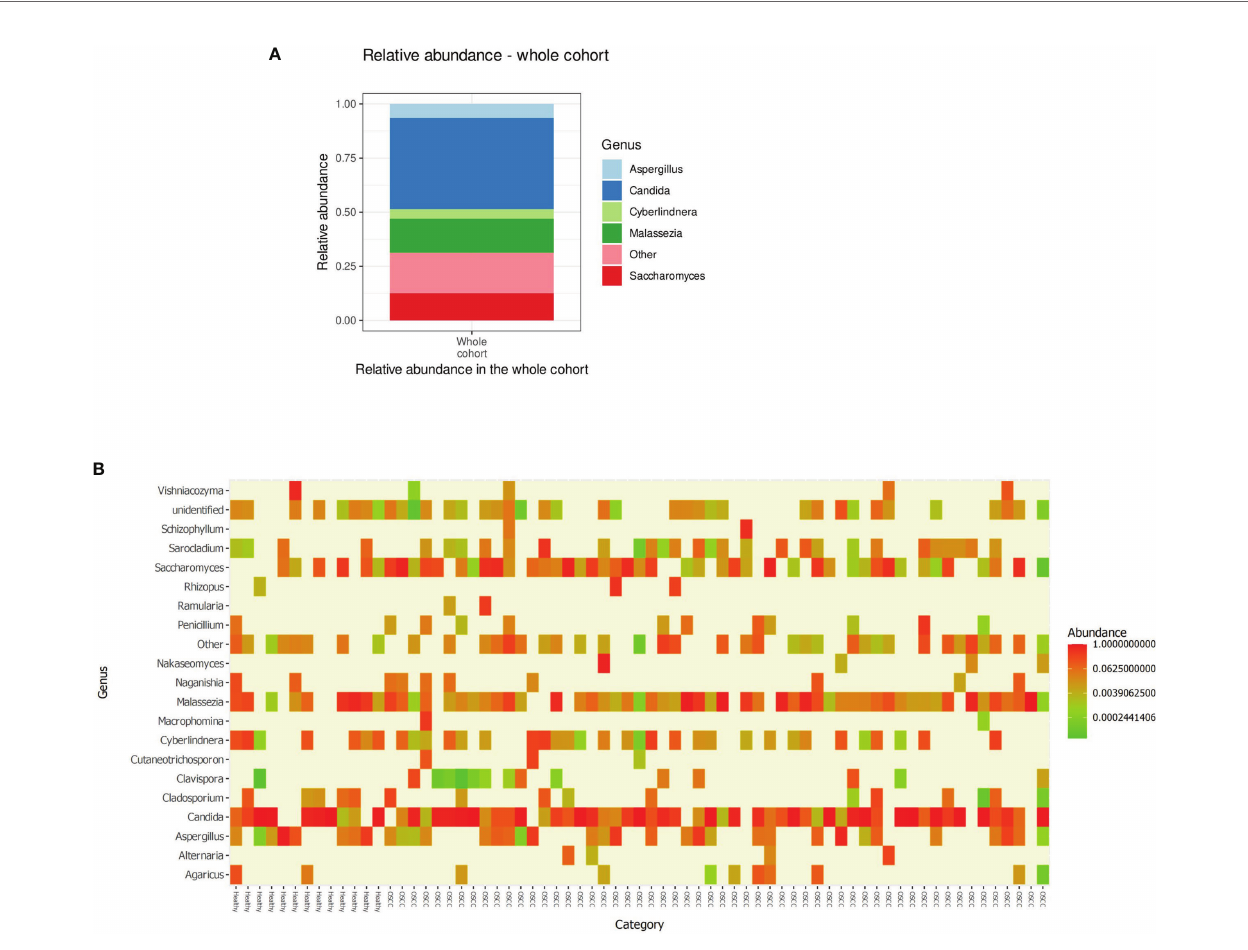
FIGURE 1 | (A) Relative abundance of the top fi ve genera in the saliva of the individuals investigated in our cohort. (B) Heat map showing the relative abundance of the top 20 genera ( X -axis sorted non-OSCC controls to the left and OSCC to the right) in each of the investigated sample. OSCC, oral squamous cell